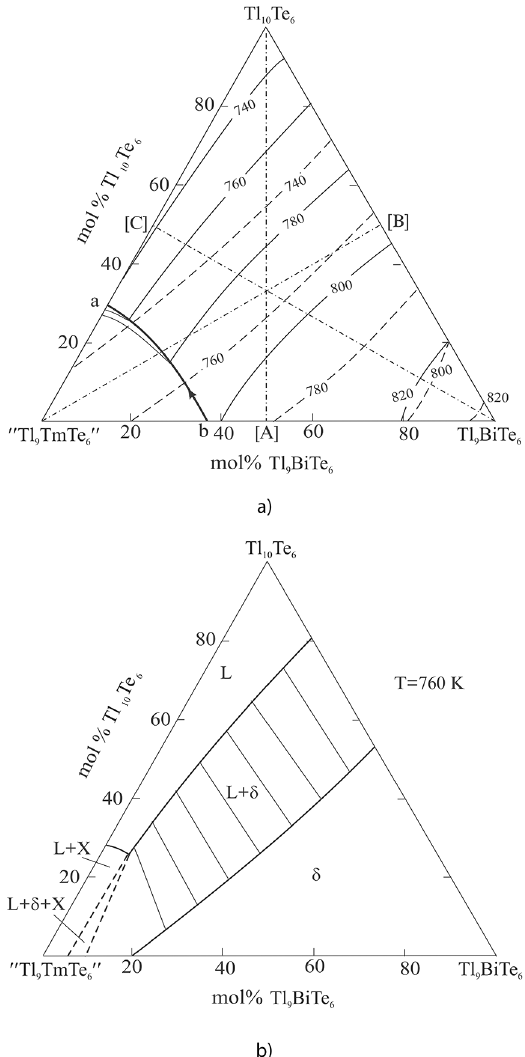
Te -Tl BiTe -Tl TmTe composition area 5 3 9 6 9 6